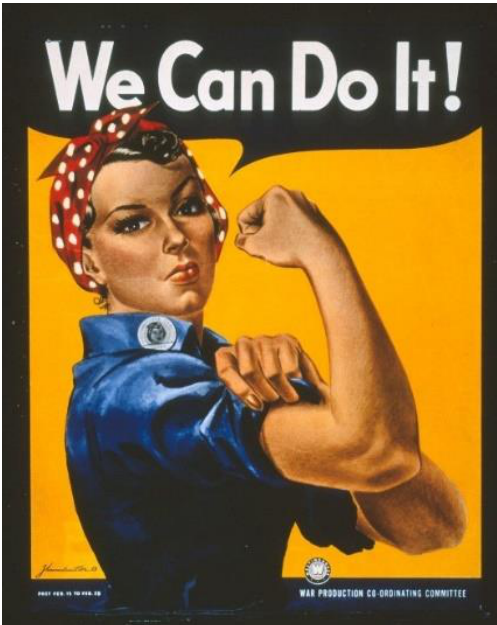
Figure 1. “We Can Do It!” World War II poster. Created by J. Howard Miller in 1942. Credit: Art Resource/Art Resource, NY.